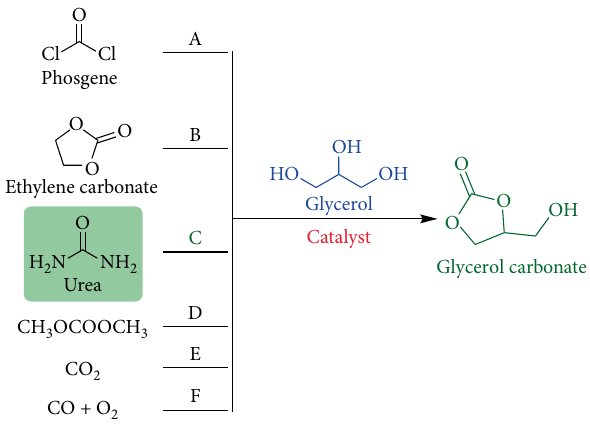
Scheme 2: Synthetic routes to glycerol carbonate.